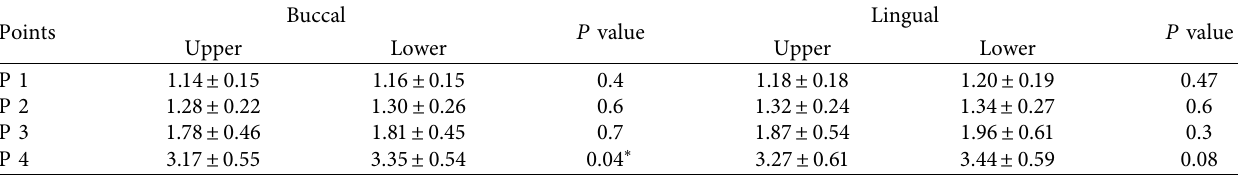
Table 3: Comparison of bone width (mm) between upper and lower jaw of dentate sites at buccal and lingual sides according to the points. Points